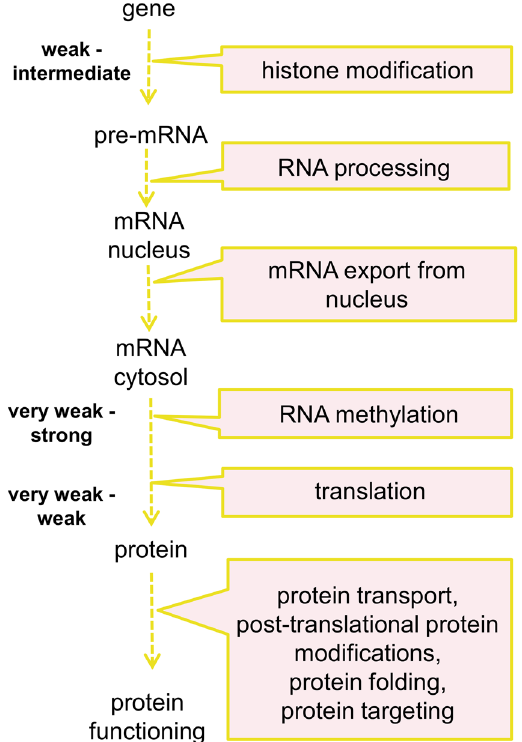
Figure 5. Gene expression control by auxin. All processes related to gene expression were upregulated in the root. Three bottlenecks are fold-change-specifically regulated by auxin, with the translation step regulated most tightly (very weak to weak levels). The source data are depicted in Fig. 4 and Supplementary Table